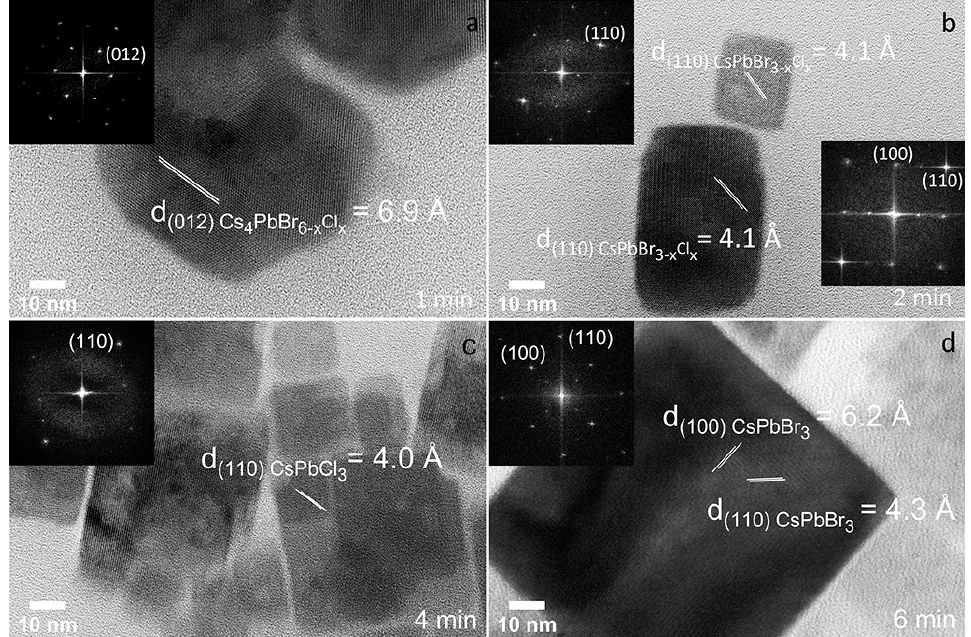
Figure 7. HRTEM images of the Cs 4 PbBr 6 − x Cl x nanohexagons after 3.6 × 10 6 pulses ( a ), CsPbBr 3 − x Cl x nanocubes after 7.2 × 10 6 pulses ( b ), CsPbCl 3 nanoplatelets after 14.4 × 10 6 pulses ( c ) and Cs 4 PbBr 3 nanosheets after 21.6 × 10 6 pulses ( d ).